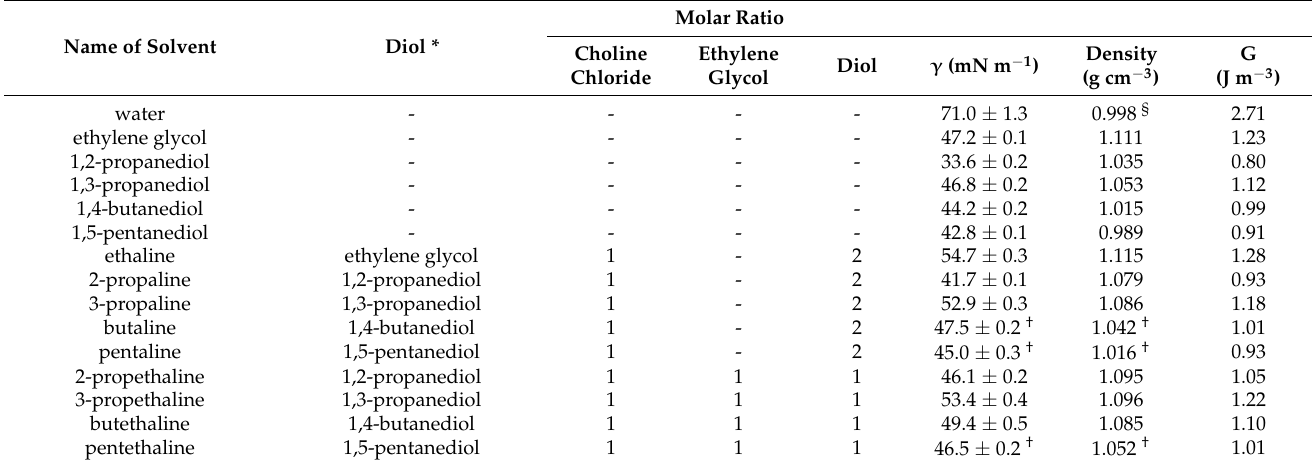
Table 1. Chosen nomenclature, compositions, measured surface tensions, densities, and Gordon parameter (G) values for each of the investigated eutectic solvent